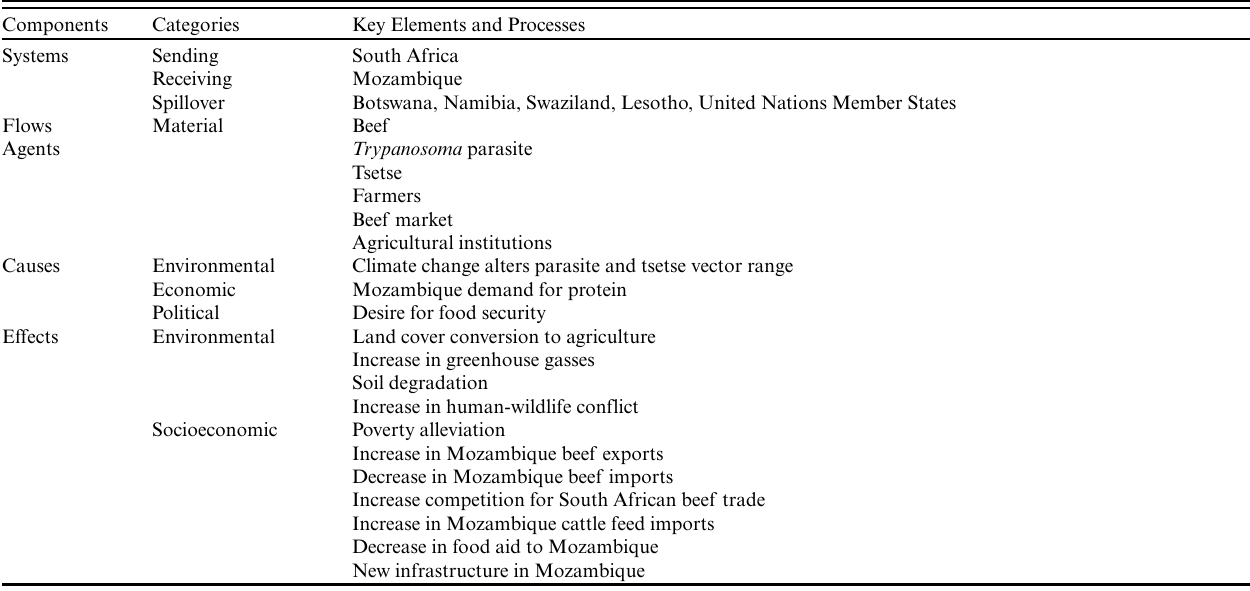
Table 1 . Summary of the telecoupling framework and the major components investigated in the context of a potential range shift of trypanosomosis in southern and eastern Africa.